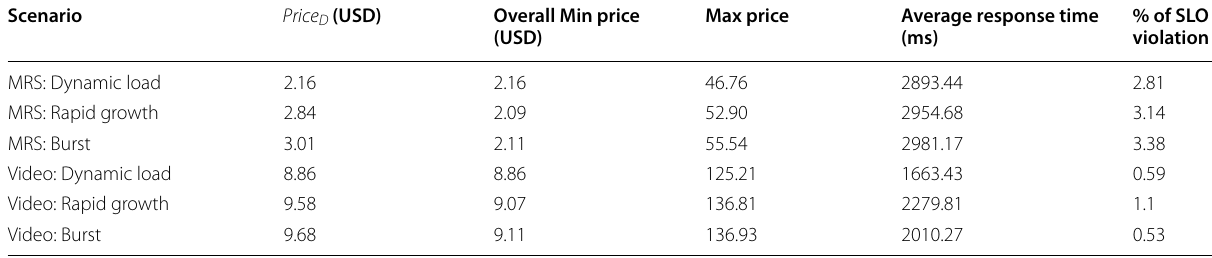
Table 12 Comparison of prices, and the values of observed QoS metrics for the deployment configuration proposed by the algorithm for each validation scenario